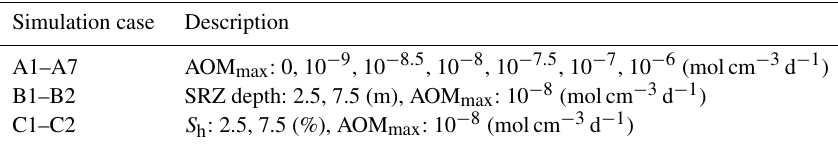
Table 2. Summary of the simulation cases performed in the present study. Each case involves 13 200-year simulations for permeabilities ranging between 10 − 17 and 10 − 14 m 2 (in total 143